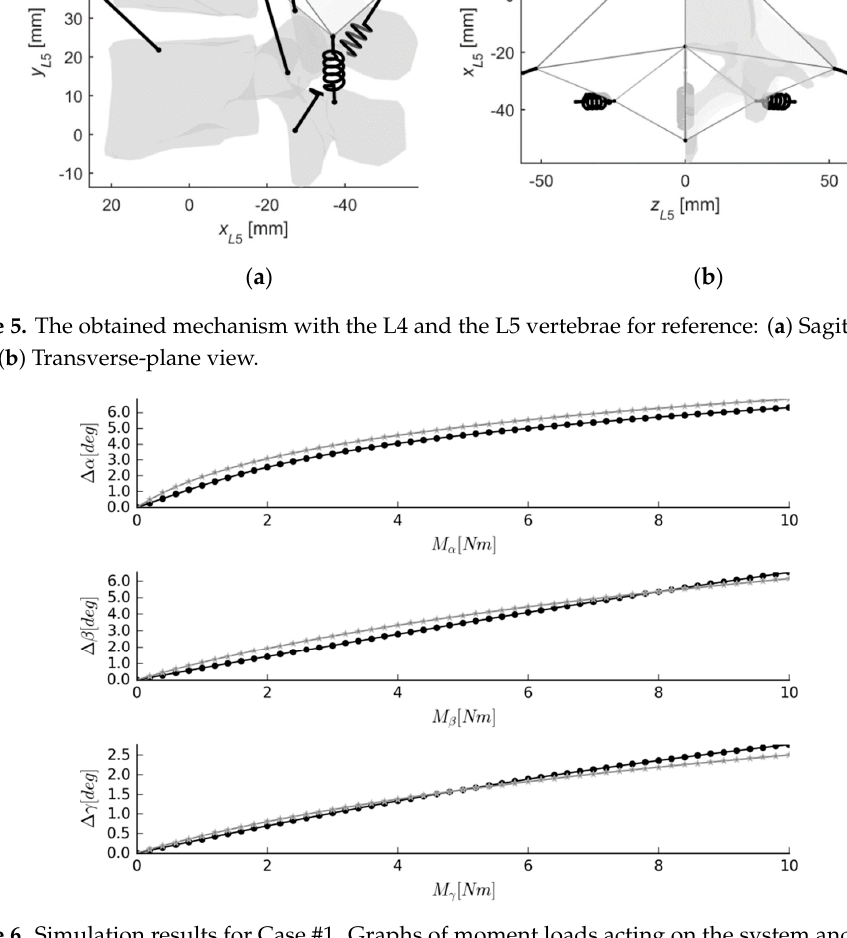
Figure 6. Simulation results for Case #1. Graphs of moment loads acting on the system and angular displacements they cause (black “·” marker = the data obtained from the mechanism, grey “*” marker = the reference data), where α = the flexion, β = the lateral bending angle, and γ = the axial rotation angle.